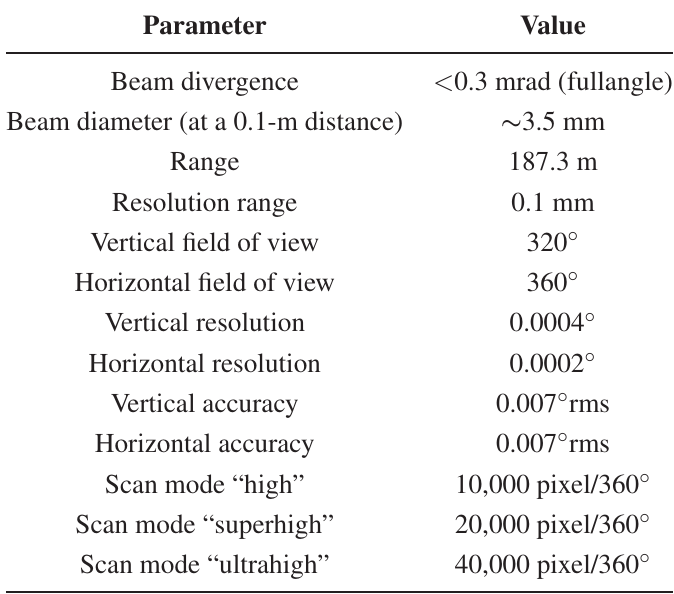
Table 1. Technical data of the Z+F IMAGER